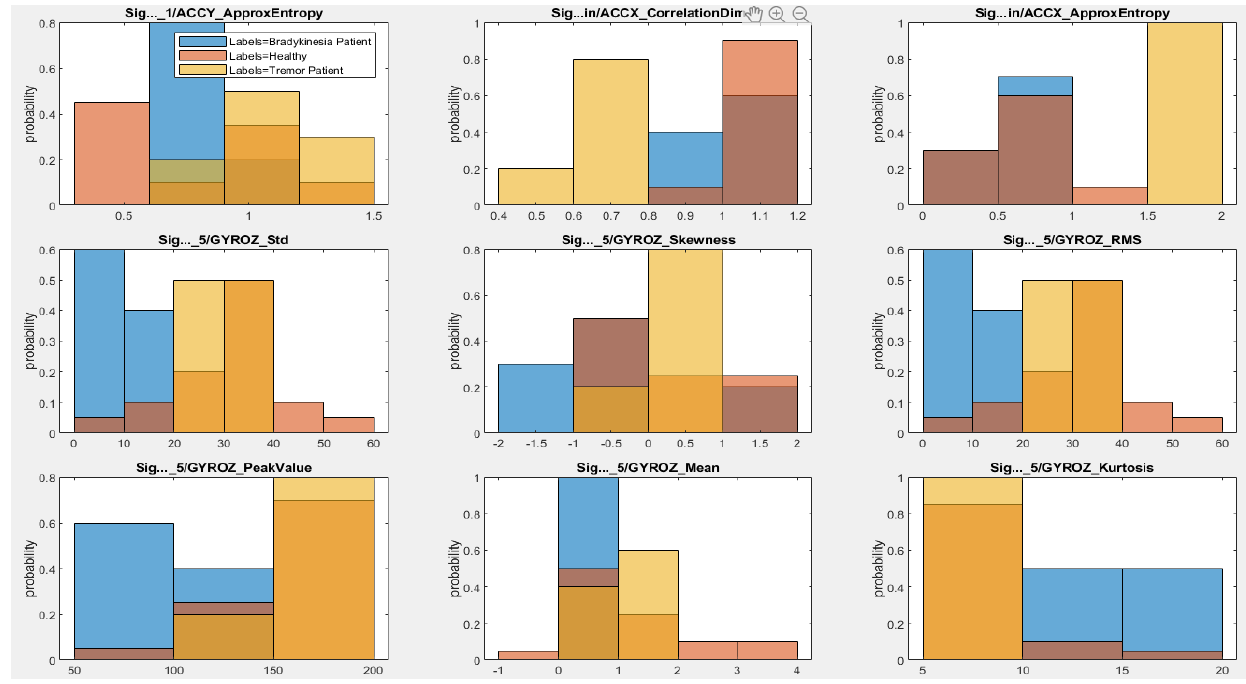
Figure 8. The histograms of the extracted